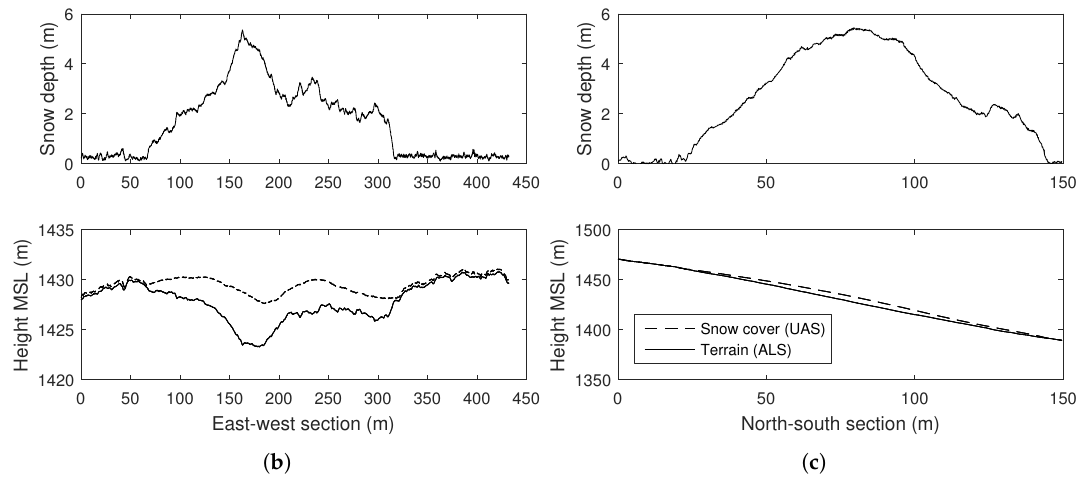
Figure 15. An interpretation of the mapping results ( a ). The UAS photogrammetry-based orthophoto is supplemented with a layer illustrating the snow depth; both items were created with the multi-sensor system for direct georeferencing. The map includes contour (solid gray) and section (dashed black) lines to facilitate the cross-section analysis. The cross-sections of the SD map, the UAS-based surface model, and the ALS-based terrain model, all passing through the SD maximum in the east-west direction, are displayed in ( b ); those that run in the north-south direction are then indicated in ( c